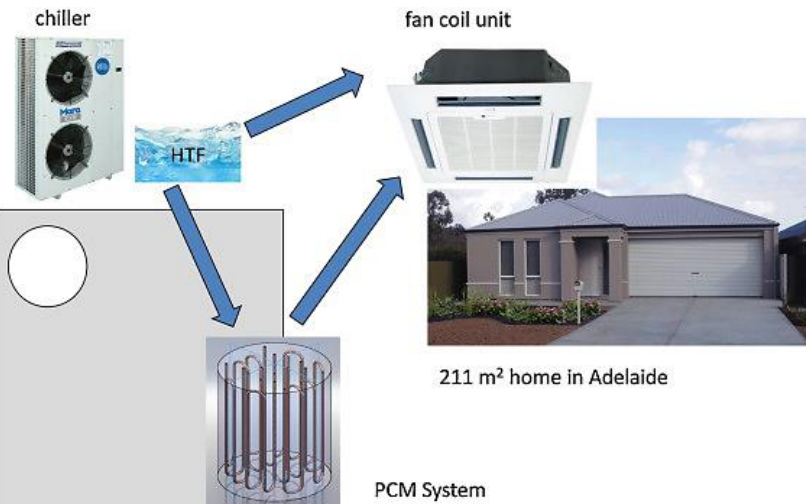
Figure 14. Domestic cooling system schematic diagram with PCM